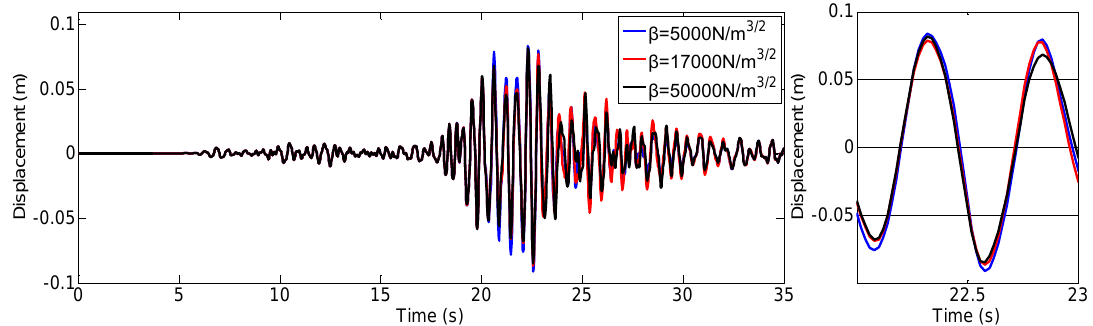
Figure 13. Displacement at the top of the tower with different pounding stiffness values.